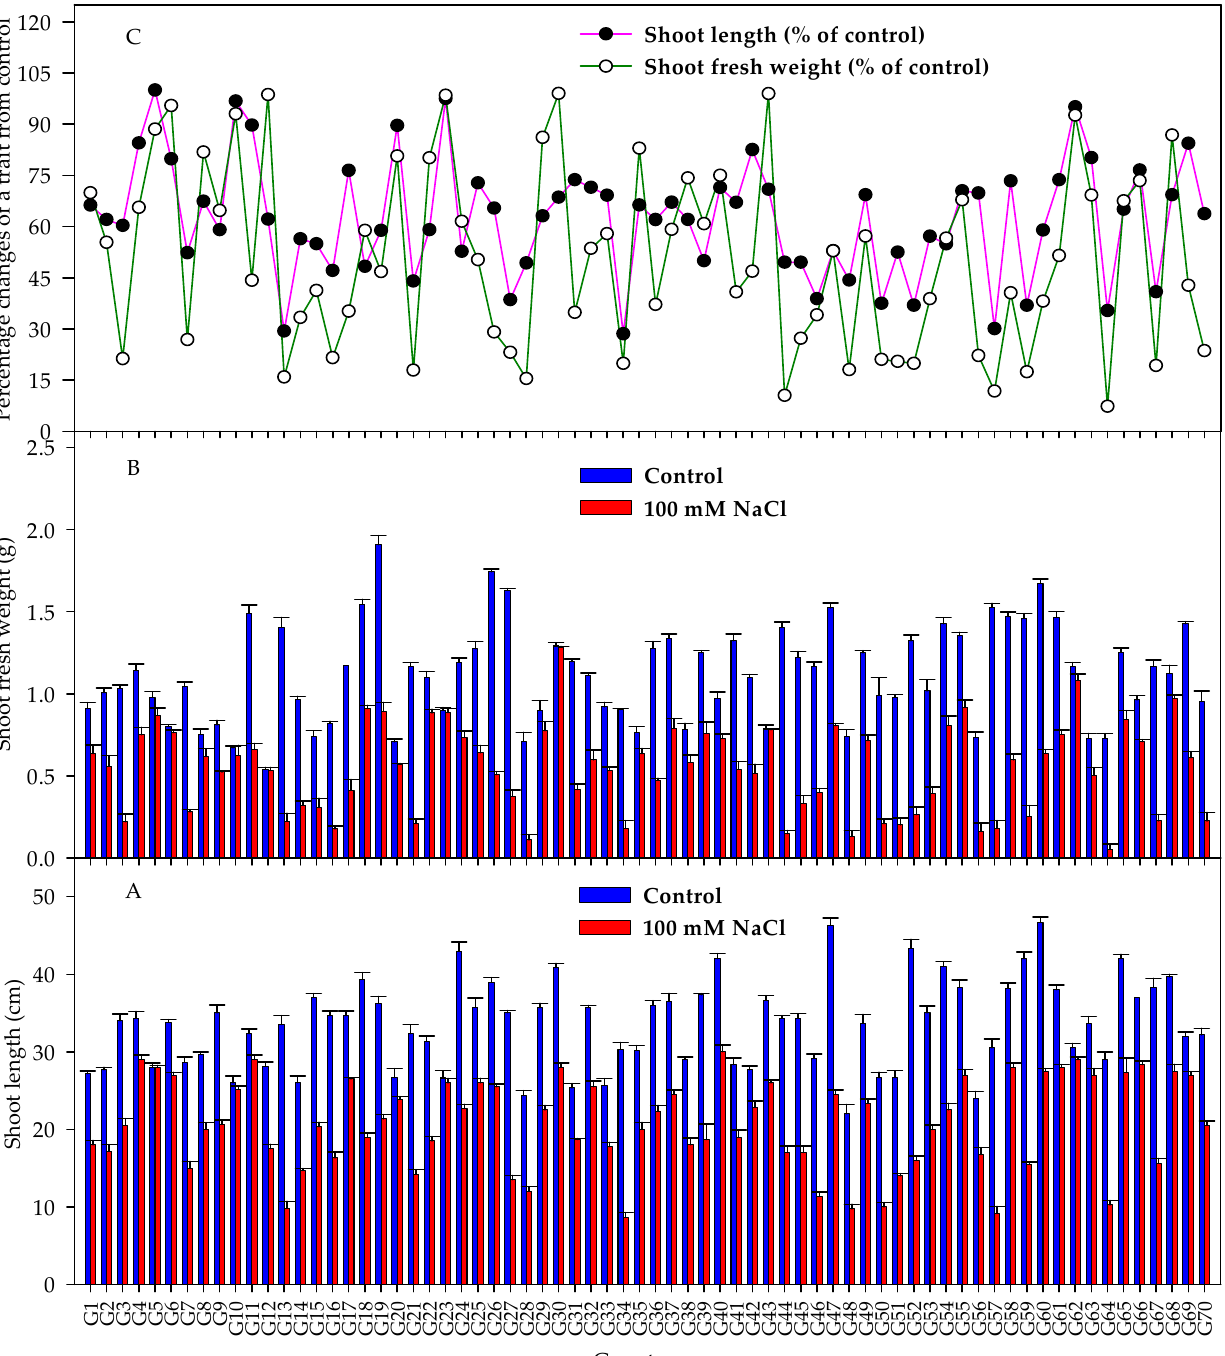
Figure 2. Shoot length ( A ), shoot fresh weight ( B ), and percentage changes of both traits from control ( C ) of 70 barley genotypes under control and 100 mM NaCl conditions. Values are means ± SE (n = 3). The full names of the different abbreviations of genotypes are listed in Table 1.